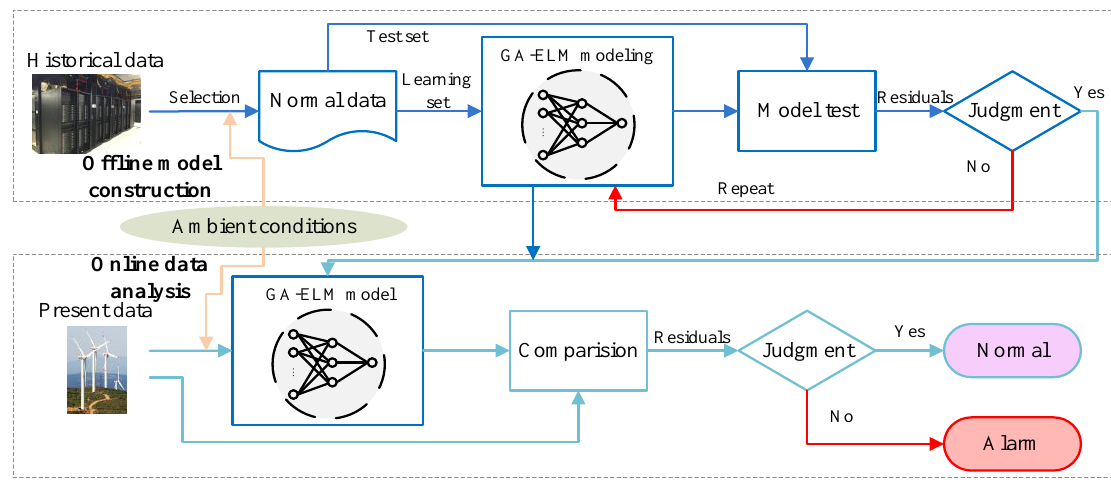
Figure 5. Framework of the proposed method.